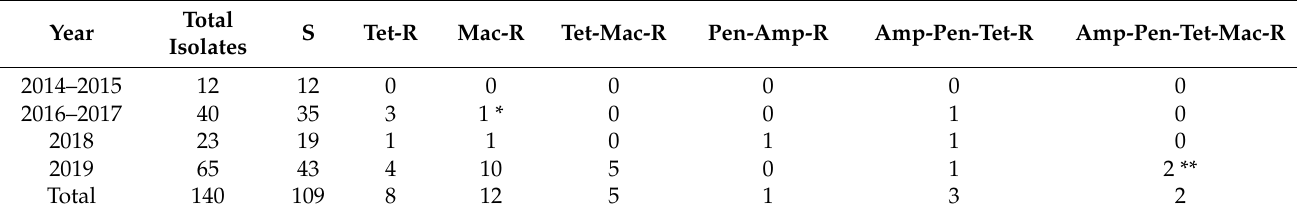
Table 7. Distribution of Pasteurella multocida isolates by year and resistance